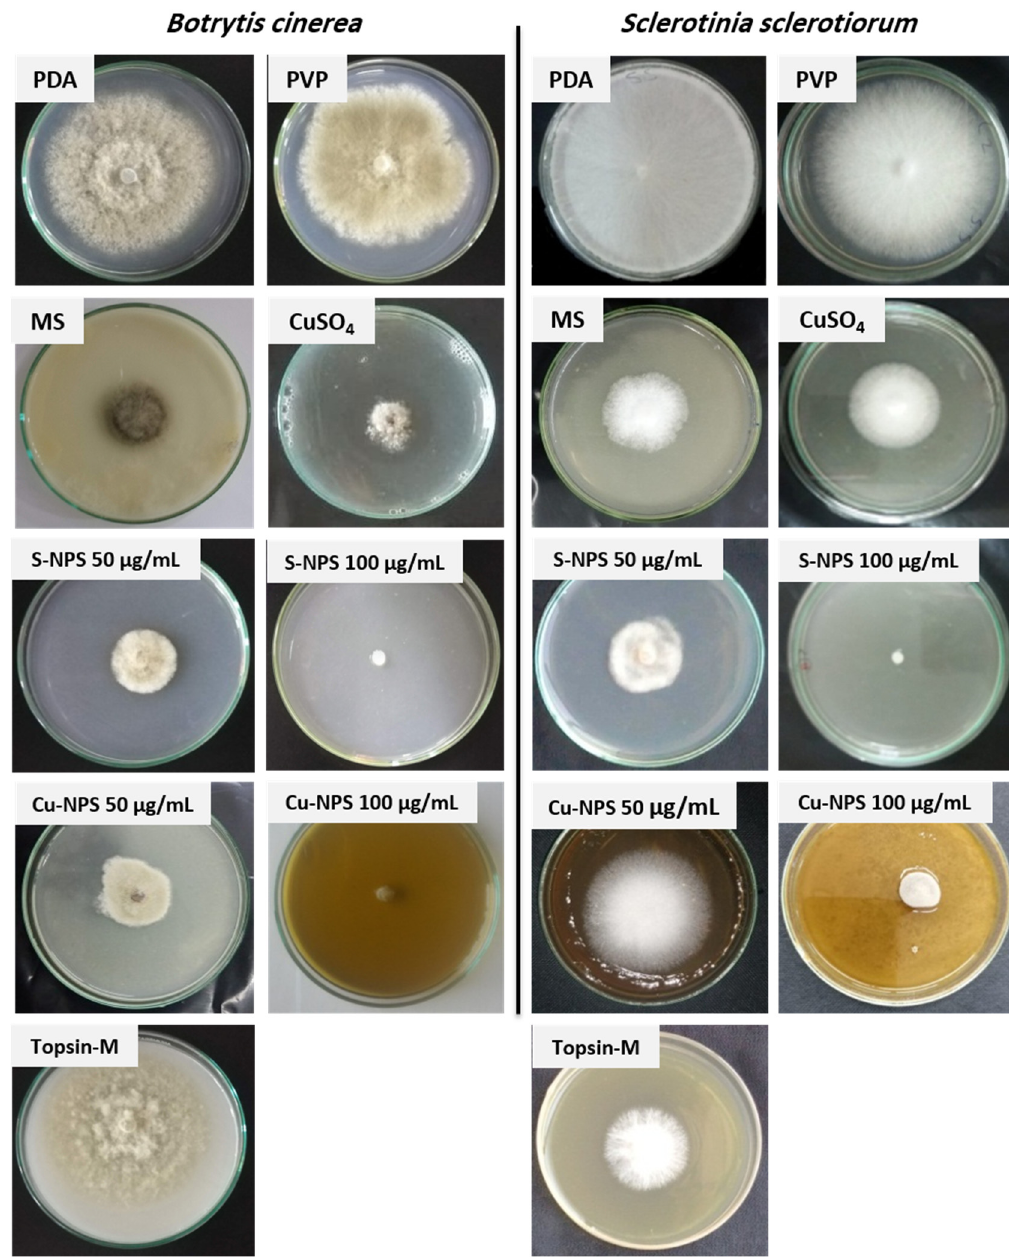
Figure 3. The antifungal activities of PVP (3 g/100 mL), MS (1000 µg/mL), CuSO 4 (4000 µg/mL), Topsin-M (1000 µg/mL), S-NPs (50 and 100 µg/mL), and Cu-NPs (50 and 100 µg/mL) against B. cinerea and S. sclerotiorum .